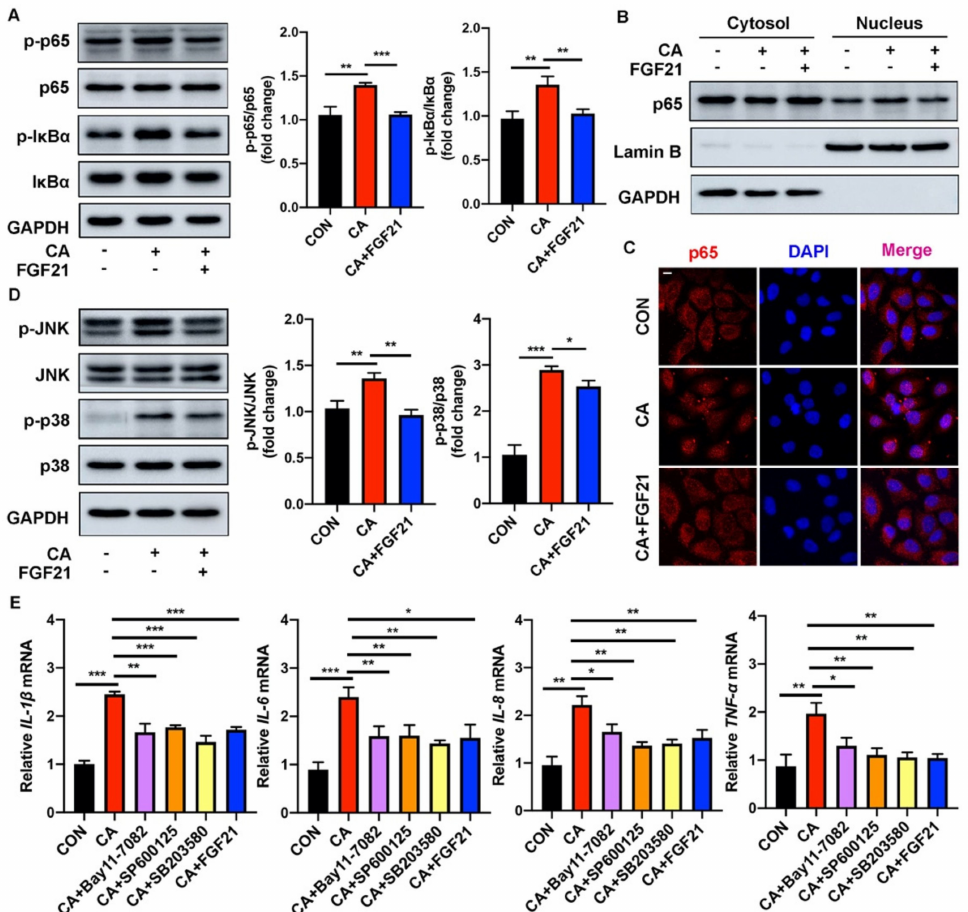
Figure 3. FGF21 suppresses C. acnes -induced proinflammatory response by inhibiting NF- κ B/MAPK signaling pathways in HaCaT cells. ( A ) Protein expression levels of p65 and I κ B in HaCaT cells stimulated with heat-killed C. acnes (1 × 10 7 CFU/mL) for 24 h with and without FGF21 treatment (20 ng/mL). ( B ) The nuclear and cytosolic fractions of p65 assayed by Western blotting. ( C ) Repre- sentative confocal scans are shown for p65 (red) and the nuclei are stained with DAPI (blue). Scale bar = 10 µ m. ( D ) Protein expression levels of JNK and p38 in heat-killed C. acnes -stimulated HaCaT cells with and without FGF21 treatment. ( E ) The mRNA levels of pro-inflammatory factors ( IL-1 β , IL-6 , IL-8 , and TNF- α ) in HaCaT cells, treated with inhibitors of NF- κ B (BAY11-7082), JNK (SP600125), p38 (SB203580), or FGF21. All data are presented as the mean ± the SD; * p < 0.05, ** p < 0.01, and *** p <